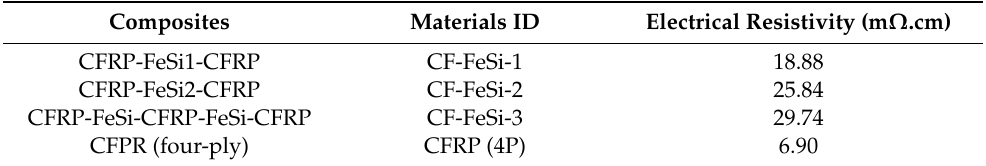
Table 4. Electrical resistivity of the